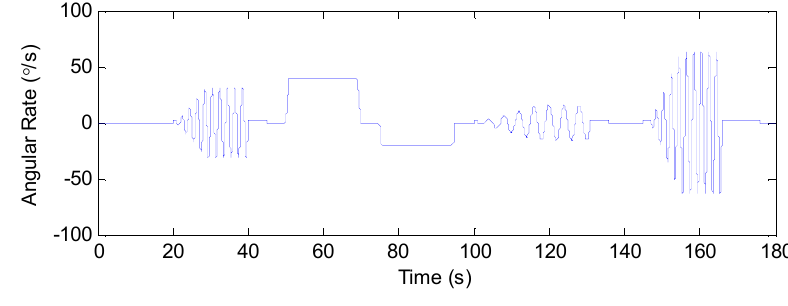
Figure 5. The true angular rate.